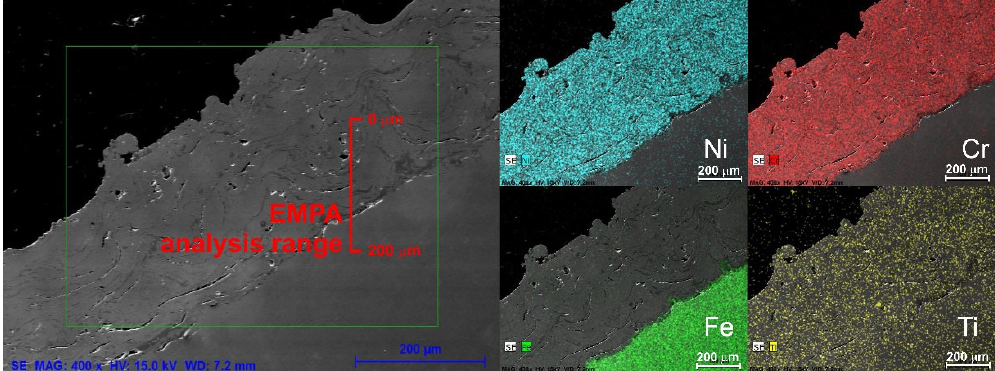
Figure 11. SEM/EDX image of the TWAS—45CT coating after 5000 h at 600 °C.